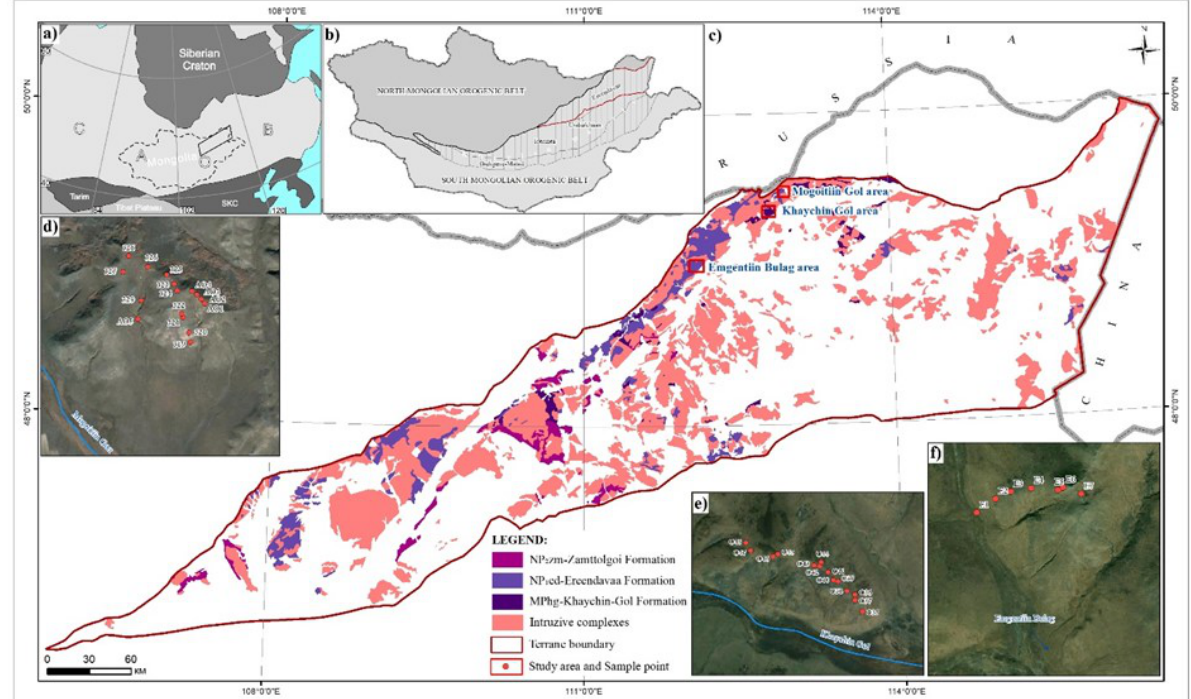
Fig. 1. a) Relationship of the study area with the Central Asian Orogenic Belt; b) Simplified tectonic zoning of fold areas in Mongolia (modified after Tomurtogoo, 2014); c) Simplified geological map of the Ereendavaa terrane (after Geology map of Mongolia with scale of 1:500000). Inset (d, e and f) shows sampling sites of each study